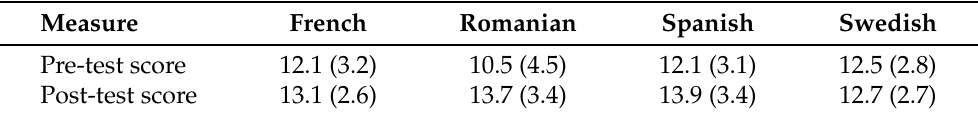
Table 1. Mean total scores on pre- and post test for the separate languages with standard deviation in